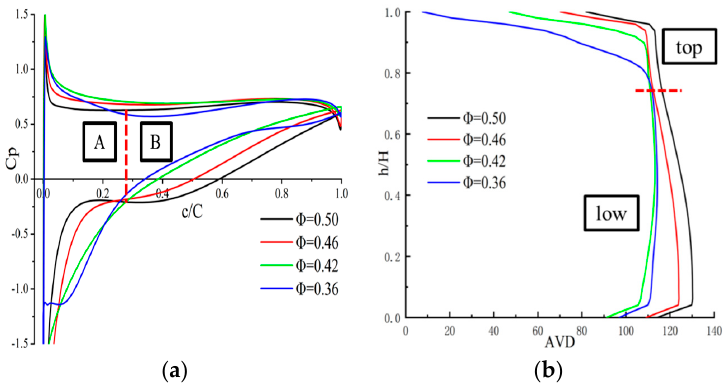
Figure 8. Static pressure and AVD. ( a ) Static pressure coefficient at 0.99 H; ( b ) AVD at the outlet of the rotor.